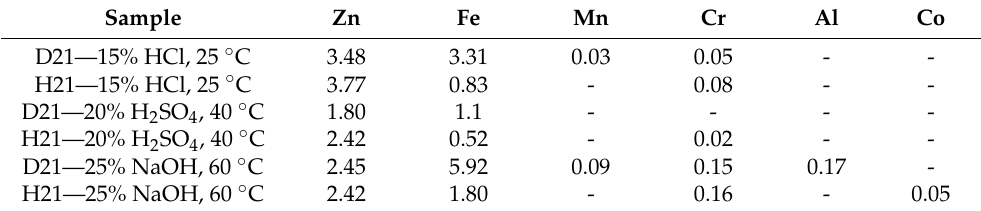
Table 14. The analyses results of the leaching residues—ED-XRF (wt.%).